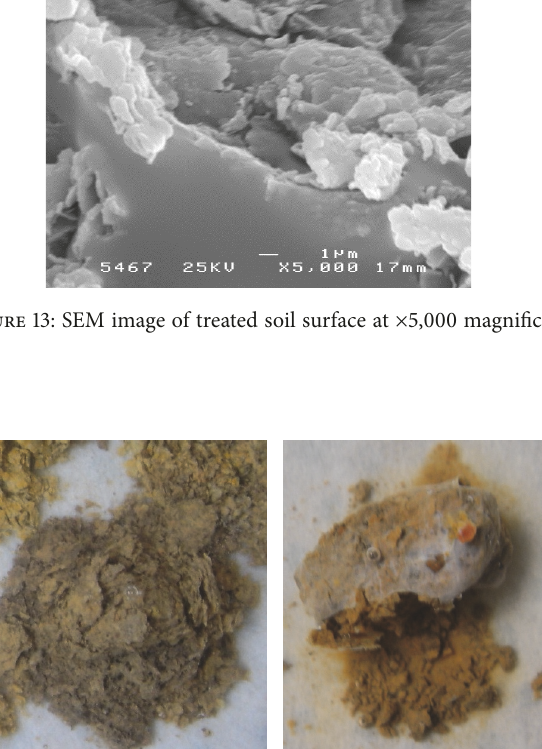
Figure 14: The photo of comparison between untreated and treated soil